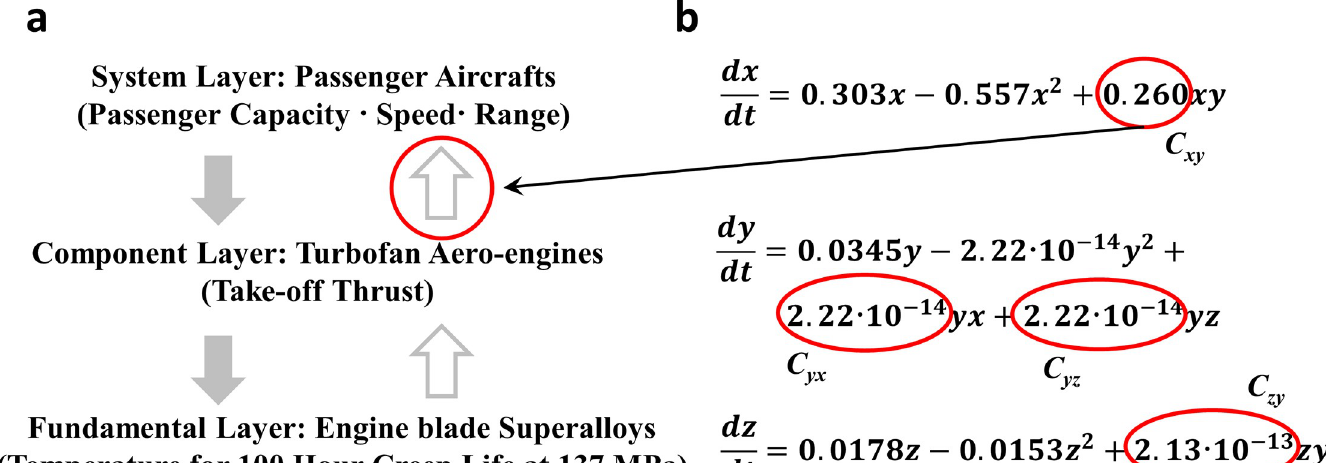
Fig 2. A simplified Lotka-Volterra ecosystem model for passenger aircraft ecosystem. a, We include only one technology in each layer of the technology ecosystem and denote the trickle-down effect by grey arrows. b, The model fitting results indicate limited trickle-down effect in the passenger aircraft ecosystem. Among the four technology interactions denoted by the grey and white arrows in the figure, only the impact from the component technology (turbofan aero-engine) on the system technology (passenger aircraft) is significant.